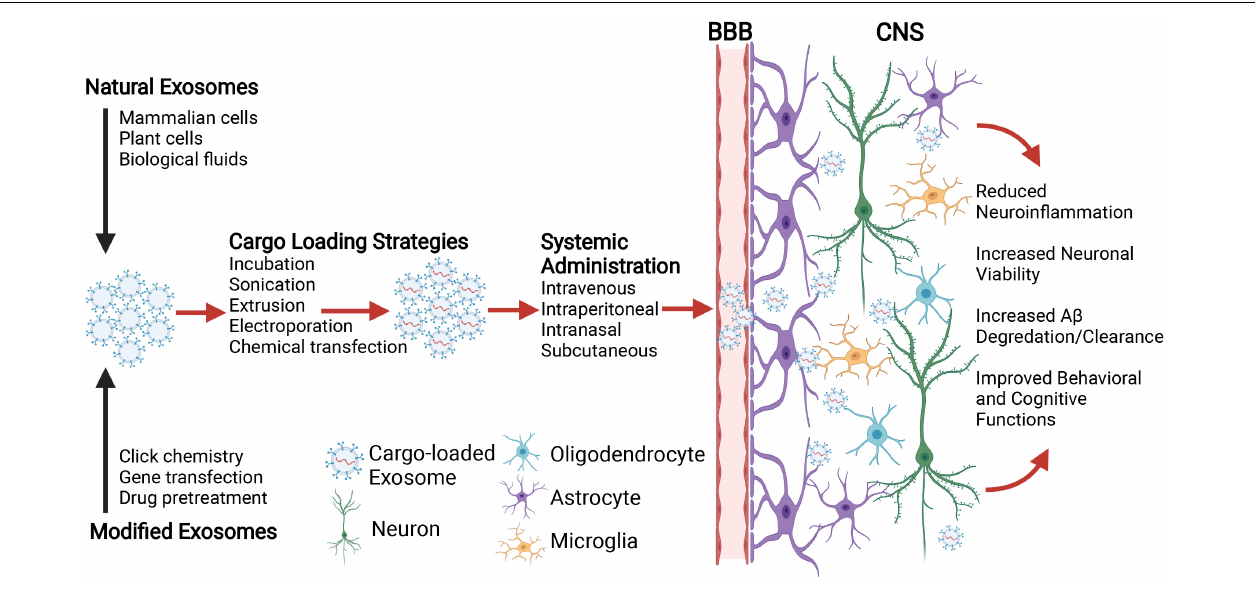
FIGURE 1 | Schematic illustration depicting the application of exosomes for central nervous system (CNS) delivery of therapeutic cargo to combat the neurobiological underpinnings of age-related cognitive decline. Natural exosomes or those modified for targeted delivery to specific brain cells (e.g., neurons, oligodendrocytes, astrocytes, and microglia) are loaded with therapeutic molecular cargo (e.g., nucleic acids, proteins, and drugs) using passive or active strategies. Exosomes are then administered systemically, where the route of administration depends upon multiple parameters including stability, biodistribution, dose, and therapeutic efficacy. With their inherent capacity to penetrate the blood brain barrier (BBB), exosomes ferry therapeutic cargos to the targeted brain cells and ameliorate aberrant neurobiological processes (e.g., neuroinflammation, neuronal cell death, A β degradation/clearance etc.) that may otherwise contribute to age-related cognitive decline. Created with Biorender.